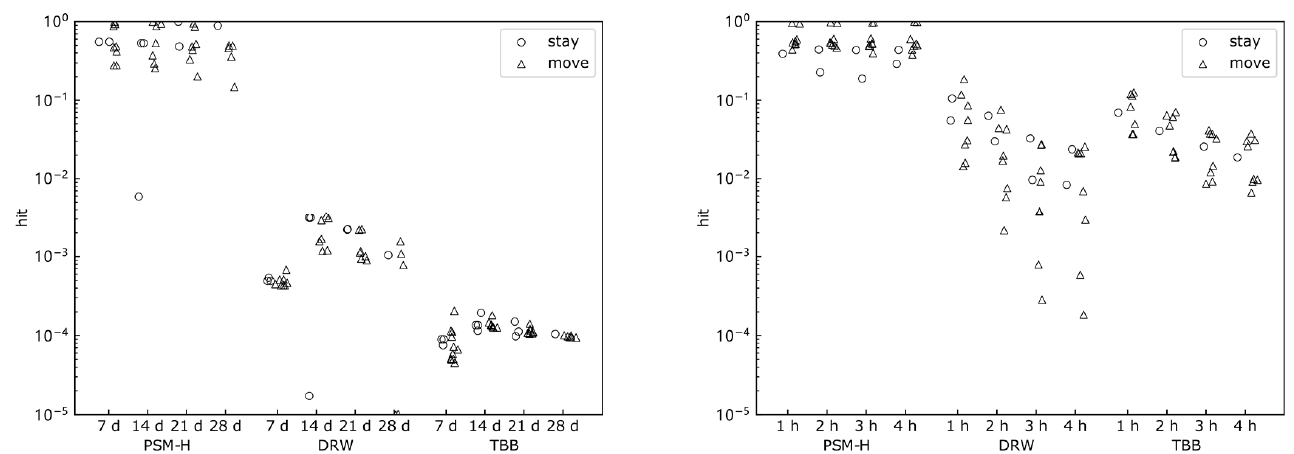
Figure 6. Hit metrics for stationary and moving episodes Left: student dataset, right: clerk dataset.